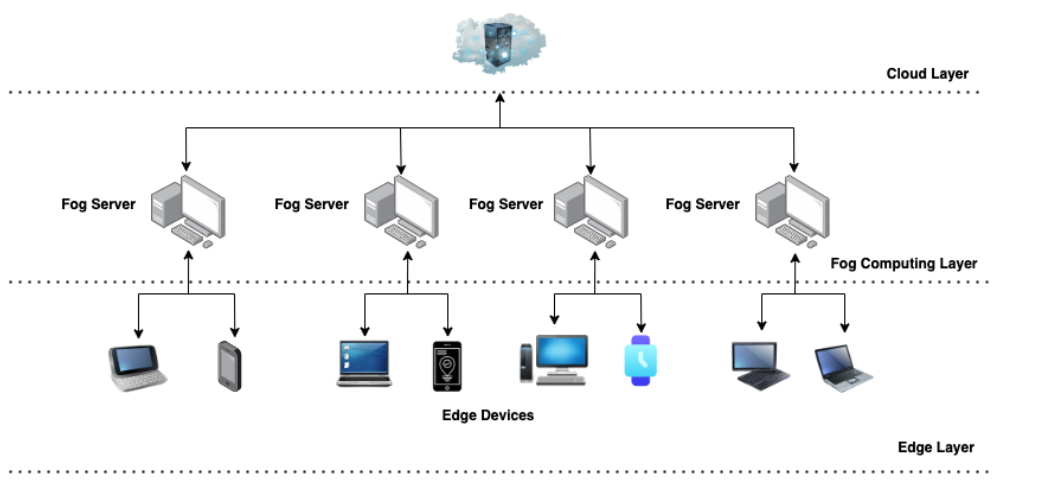
Figure 2. Authentication system built on Neo blockchain and fog